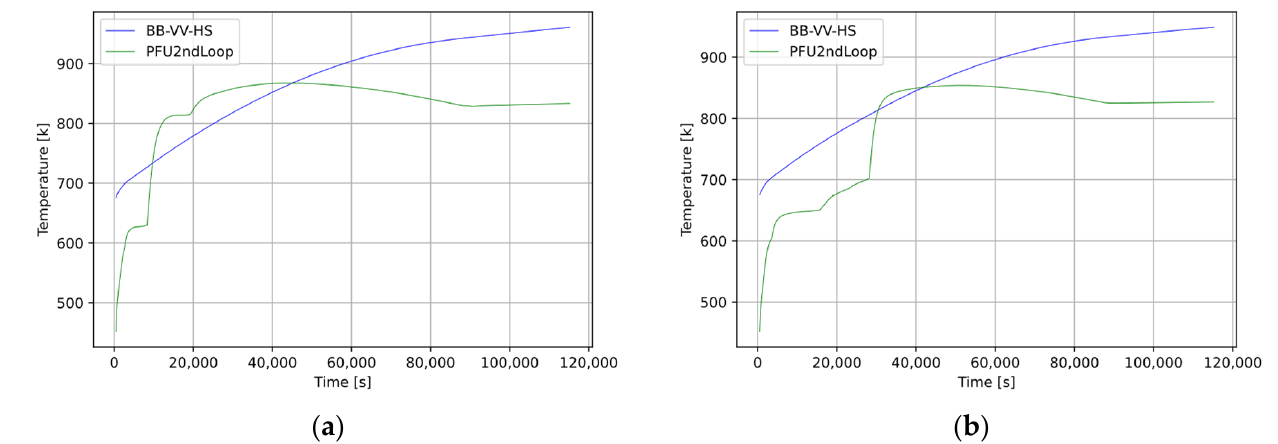
Figure 15. Long-term temperature pattern in other in-VV HS PIE1 ( a ) and PIE2 ( b ) cases.